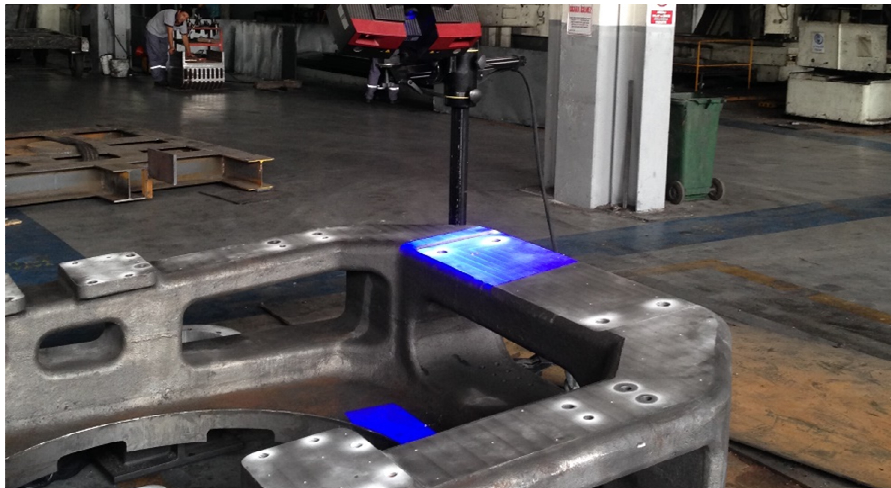
Figure 15. Quality control of the cast part.